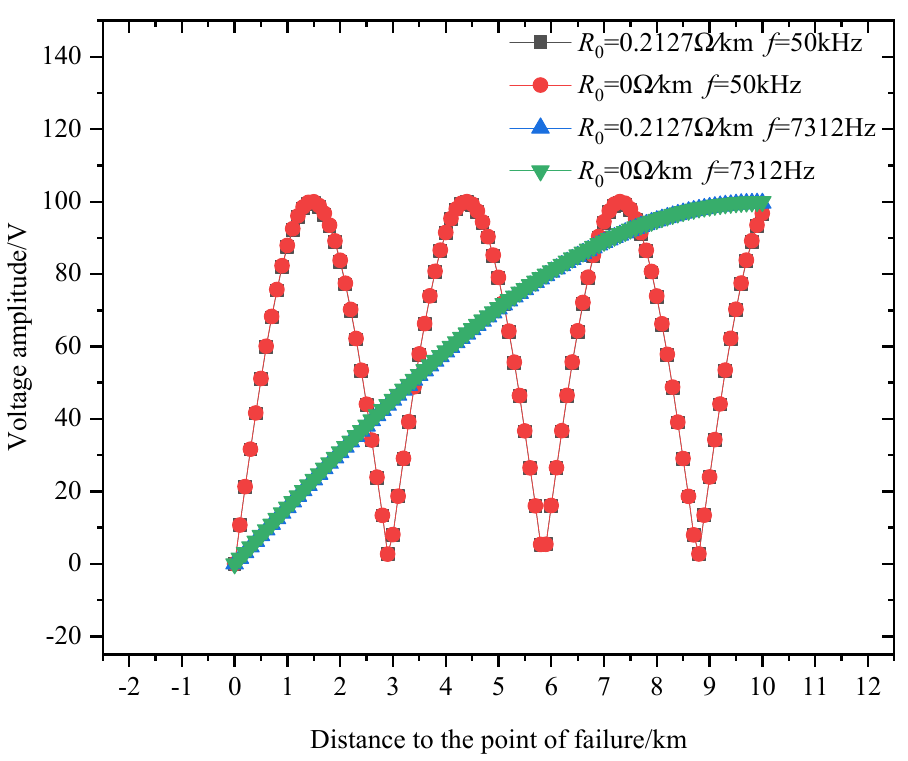
Figure 5. Simulation distribution of lossy and lossless standing waves at different